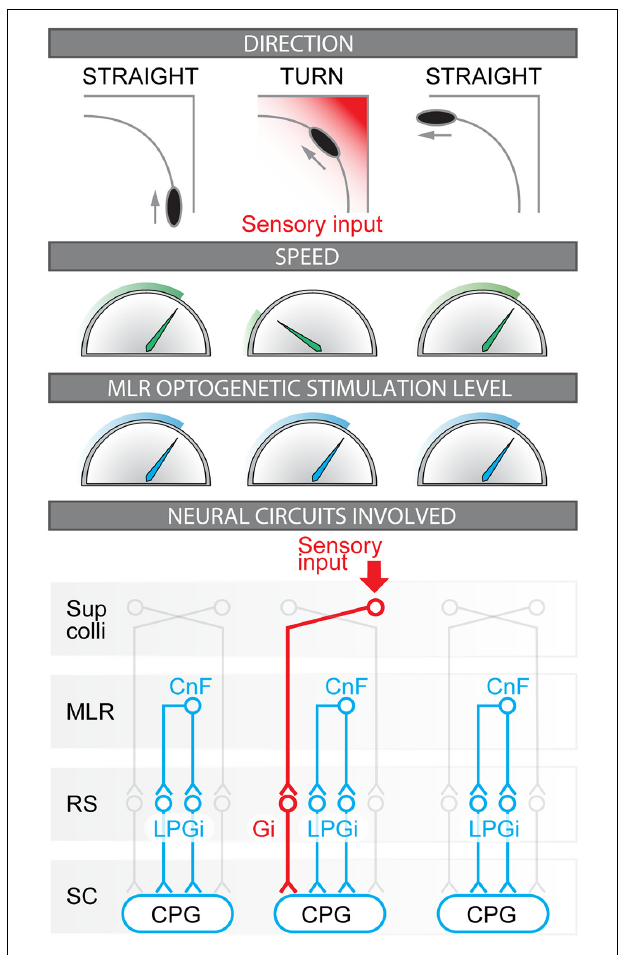
FIGURE 7 | Coordinated control of locomotor speed and turning movements during optogenetic stimulation of the Mesencephalic Locomotor Region (MLR). Illustration of the relation between motion direction, locomotor speed, and MLR optogenetic stimulation level in the present study. The neural circuits likely involved before, during, and after the turn are illustrated. Before the turn, forward locomotion is evoked by unilateral stimulation of glutamatergic neurons of the cuneiform nucleus (CnF, part of the MLR) that provides bilateral activation of reticulospinal (RS) neurons located in the lateral paragigantocellular nucleus (LPGi) that project to the spinal neurons of the central pattern generator (CPG) for locomotion (mouse Bretzner and Brownstone, 2013; Lee et al., 2014; Roseberry et al., 2016; Capelli et al., 2017; Josset et al., 2018; Caggiano et al., 2018). Also see corresponding studies in lamprey (Buchanan and Grillner, 1987; Brocard and Dubuc, 2003; Le Ray et al., 2003; Brocard et al., 2010), zebrafish (Kinkhabwala et al., 2011; Kimura et al., 2013), and salamander (Cabelguen et al., 2003; Ryczko et al., 2016a). During the turn, the visual inputs conveying the approach of the corner are relayed by the superior colliculus (Sup Colli) that sends projections to contralateral reticulospinal neurons of the gigantocellularis nucleus (Gi) that evoke ipsilateral braking and turning movements (Bouvier et al., 2015; Cregg et al., 2020; Usseglio et al., 2020); also see studies on the role of reticulospinal neurons in steering control in lamprey (Deliagina et al., 2000; Fagerstedt et al., 2001; Kozlov et al., 2014; Suzuki et al., 2019), zebrafish (Huang et al., 2013; Thiele et al., 2014), salamander (Ryczko et al., 2016c) and rat (Oueghlani et al., 2018). After the turn, the sensory inputs generated by the corner disappear, Gi neurons are deactivated, speed increases back to the value set by the steady MLR command, and forward symmetrical locomotion is